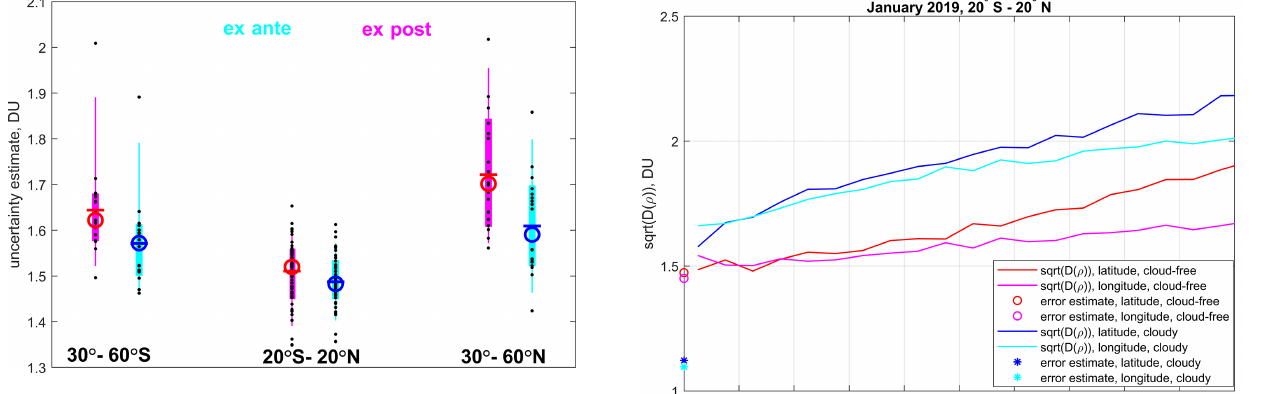
Figure 6. The distributions of experimental uncertainty estimates using the structure function method (ex post: magenta and red color) and the theoretical values by the inversion algorithm (ex ante: cyan and blue color) in the tropics and at mid-latitudes. Black dots show individual values, circle is median, horizonal dash is mean, thick vertical lines span over 16th–84th inter-percentile range, thin verti- cal lines span over 5th–95th inter-percentile range of the uncertainty estimates.